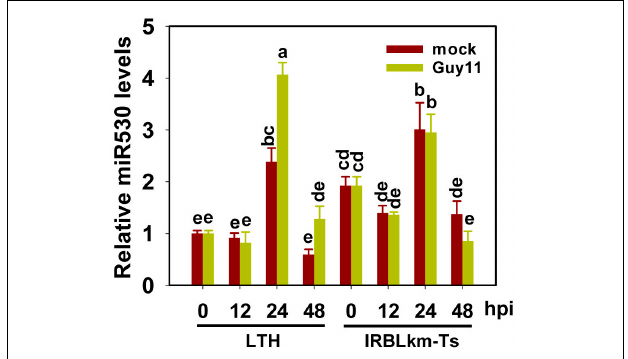
FIGURE 1 | miR530 is differentially responsive to blast fungus in susceptible and resistant accessions. The data of reverse-transcription quantitative PCR (RT-qPCR) show miR530 levels in Lijiangxin Tuan Heigu (LTH) and International Rice Blast Line Pyricularia-Kanto51-m-Tsuyuake (IRBLKm-Ts) with or without Magnaporthe oryzae treatment. The data are shown as mean ± SD ( n = 3 independent samples). The mRNA levels were normalized to that of the mock sample of LTH at 0 h postinoculation. Different letters above the bars indicate significant differences ( P < 0.01) as determined by the one-way ANOVA